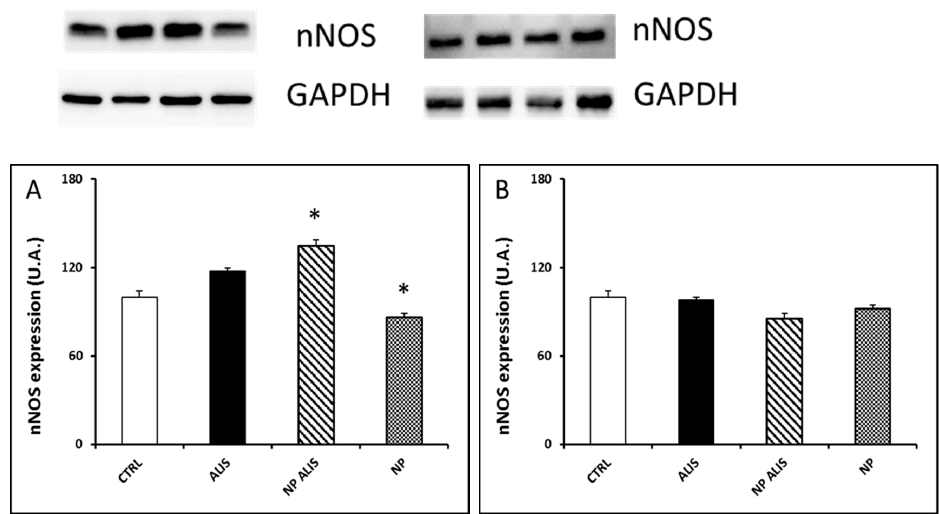
Figure 7. Effect of powdered aliskiren (ALIS), nanoparticle-loaded aliskiren (NP ALIS), and nanoparticles only (NP) on endothelial nitric oxide synthase (eNOS) protein expression in the left ventricle ( a ) and aorta ( b ). * p < 0.01 vs. CTRL; Values represent mean ± SEM of 6 animals.